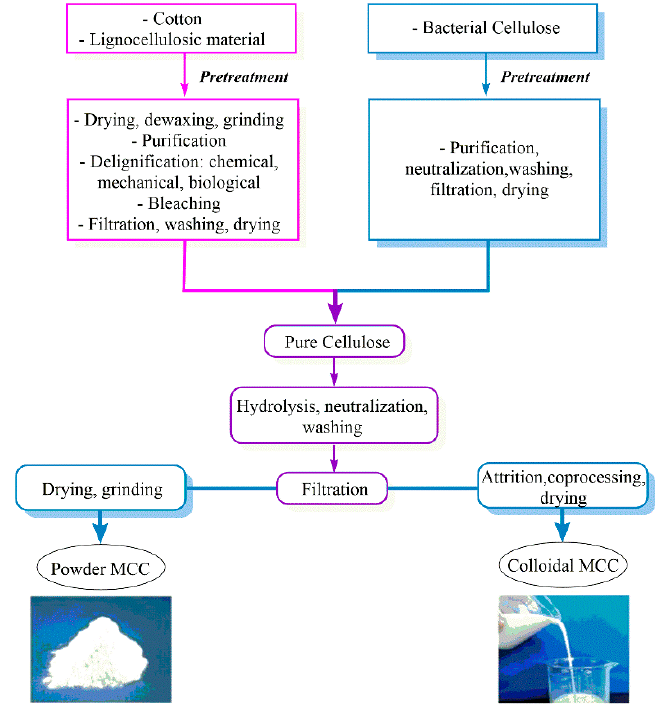
Figure 2. Production of MCC from cellulose-based materials [7].